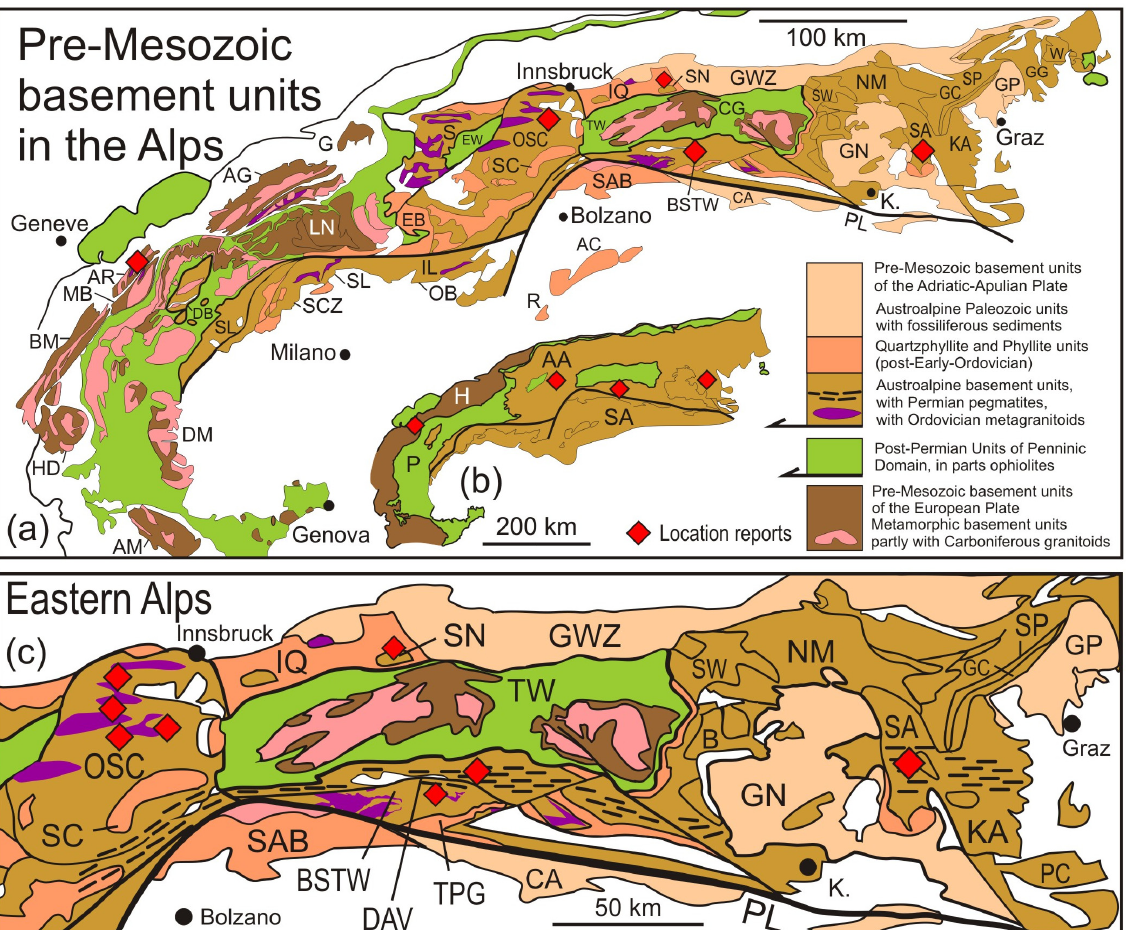
Figure 1. ( a ) Pre-Mesozoic basement units in the Alps [4]. ( b ) Subdivision of the basement units in Austroalpine (AA), Helvetic (H), Penninic (P) and South Alpine (SA) Domains. ( c ) Basement units in the Austroalpine Domain with locations of reports (red marks). Basement units and massifs, and major tectonic lines: AC Agordo-Cereda; AG Aar-Gotthard; AM Argentera Massif; AR Aiguilles Rouges Massif; B Bundschuh; BM Belledonne Massif; BSTW Basement South of Tauern Window; CA Carnic Alps; CG Central Gneisses; DAV Defereggen-Antholz-Vals Line; DB Dent Blanche; DM Dora Maira; EB Err-Bernina; EW Engadine Window; G Glarus; GC Gleinalm Complex; GG Grobgneis Complex; GN Gurktal nappes; GP Graz Paleozoic; GWZ Greywacke Zone; HD Haute Dauphiné; IL Insubric Line; IQ Innsbruck Quartzphyllite; KA Koralpe; LN Lepontine Nappes; MB Mont Blanc; NM Niedere Tauern and Micaschist Complexes; OB Orobic Basement; OSC Oetztal-Stubai Complex; PC Pohorje Complex; PL Periadriatic Lineament; R Recoaro; S Silvretta; SA Saualpe; SAB South Alpine Basement; SC Schneeberg Complex; SCZ Seconda Zona Diorite Kinzigite; SL Sesia-Lanzo Zone; SN Steinkogel nappe; SP Speik Complex with Kraubath ophiolite; TPG Thurntaler Phyllite Group; TW Tauern Window; W Wechsel Gneiss Complex.